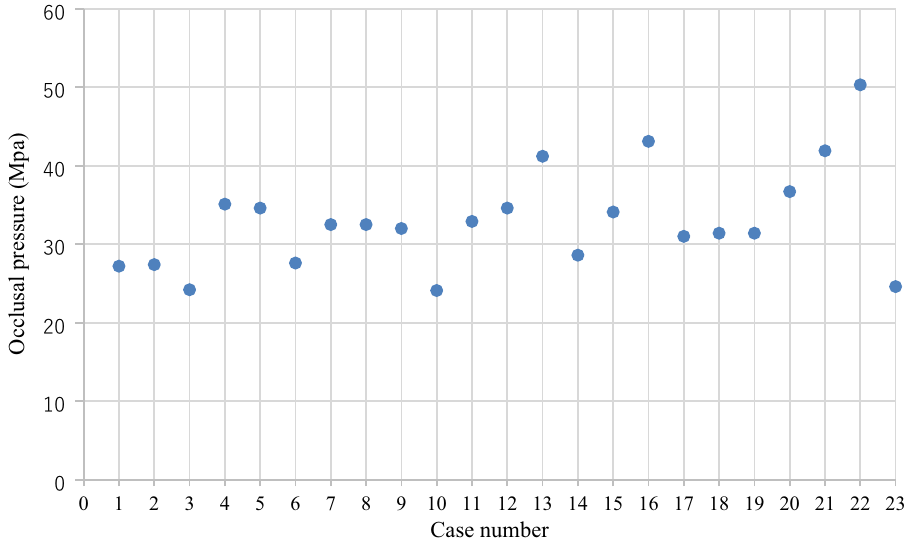
Figure 7. Distribution for the 23 Cases of Occlusal pressure evaluated by Dental prescale II system. *Plots represent mean Occlusal pressure for each case.